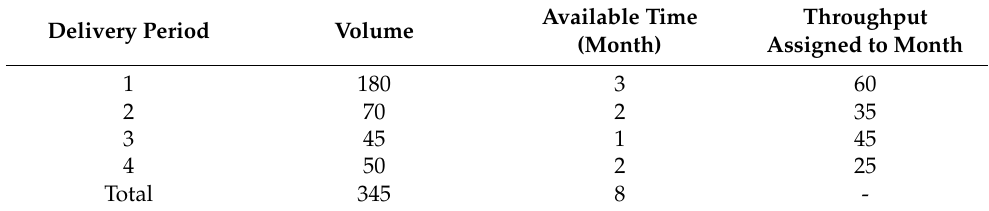
Table 6. Information of Order